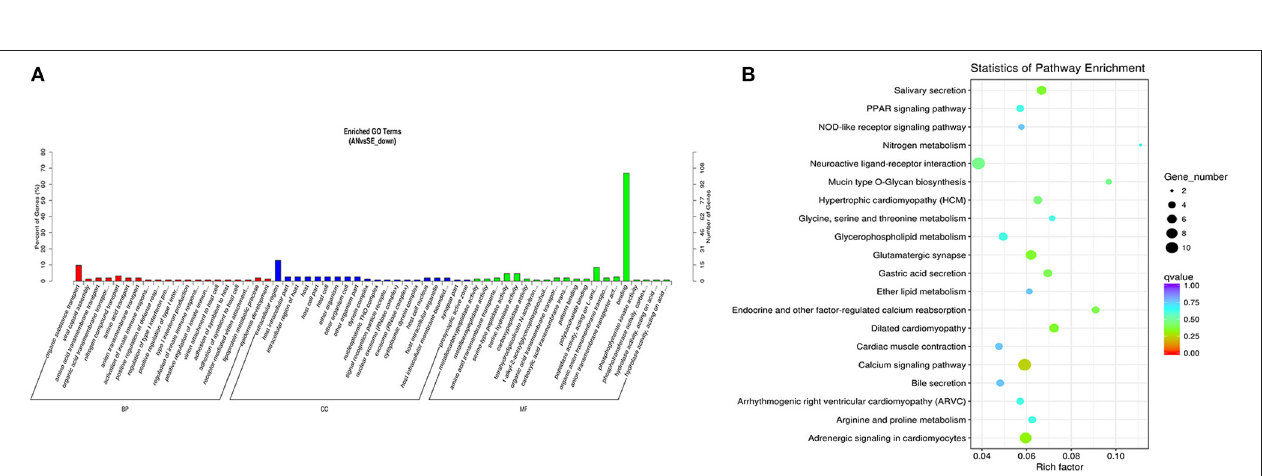
FIGURE 10 | Top annotated GO terms (A) and KEGG pathways (B) of trans-target genes of the downregulated DE lncRNAs.